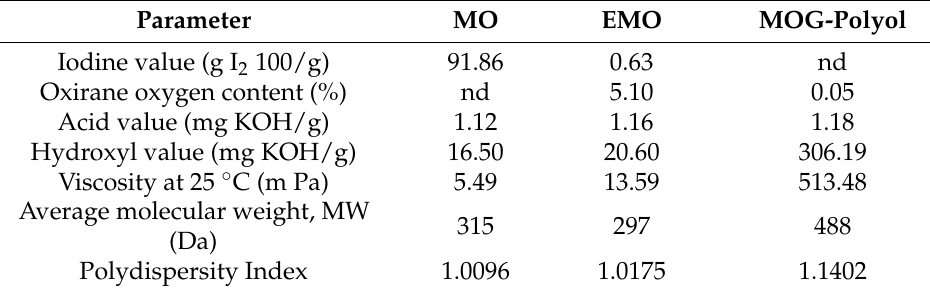
Table 7. Characteristics of MO, EMO and